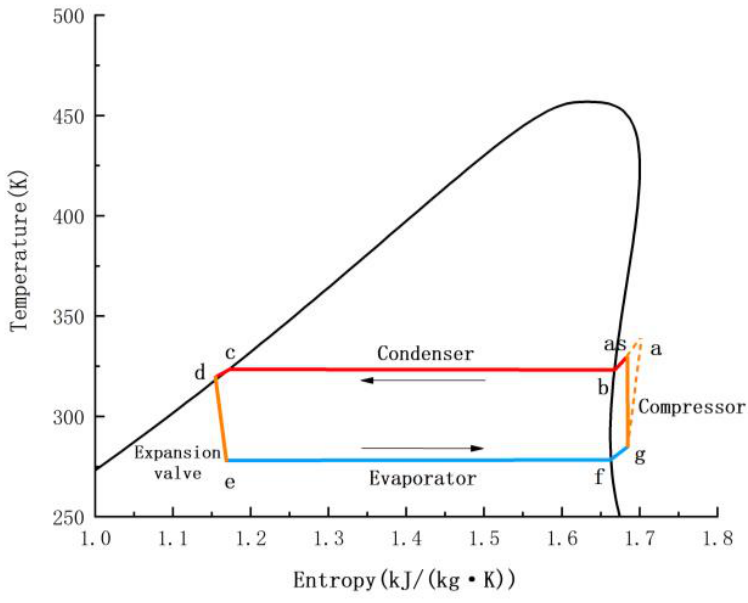
Figure 4. T – S diagram of the heat pump cycle (working fluid: R123). Figure 4. T–S diagram of the heat pump cycle (working fluid: